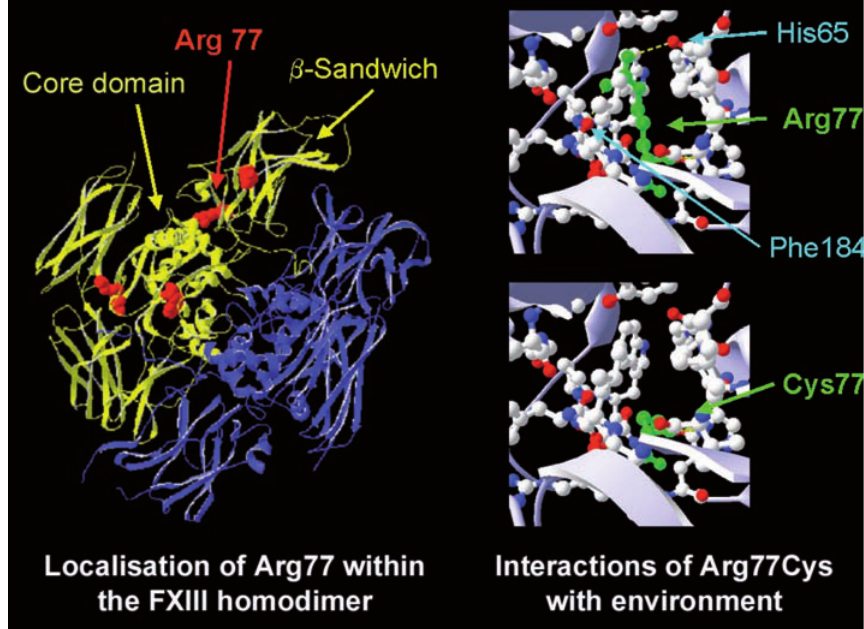
Figure 3 Structural analysis of the mutation Arg77Cys found in the tribe of Uri Left: FXIII A 2 homodimer (the two monomers are displayed in yellow and blue). Wild-type Arg77 is located at a critical site between the b -sandwich and core-domain. Right: Top: Wild-type Arg77 (green) forms hydrogen bonds (yellow dashes) with His65 and Phe184. Bottom: Mutant Cys77 (green) forms no hydrogen bonds and leaves an open gap. (Modified from [16] and reproduced with permission from the